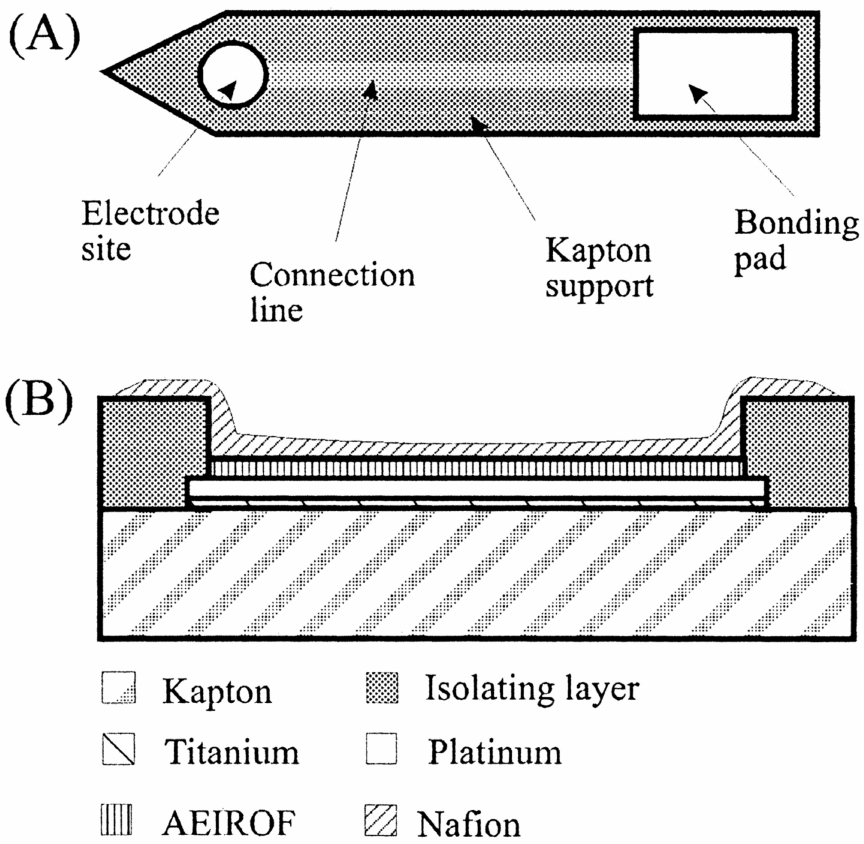
Figure 7. ( A ) Kapton-based single planar electrodes. The edge was tapered to facilitate the electrode implantation in the myocardium. ( B ) The layer structure of the AEIROF-based planar pH electrode. Reprinted from the permission of reference [19]. Copyright 1998, American Chemical